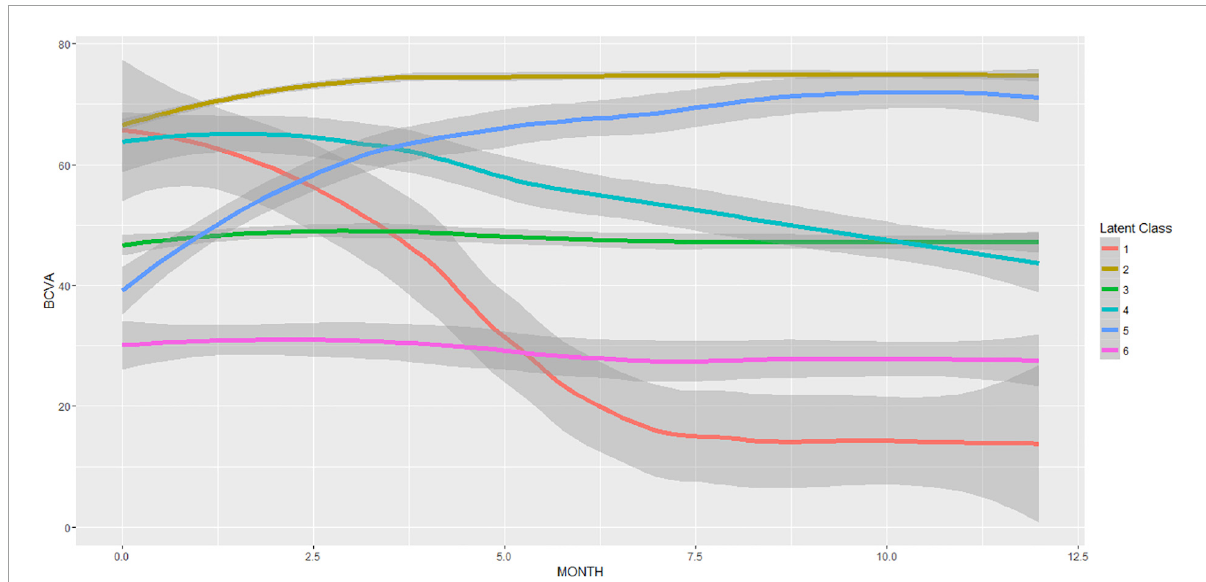
FIGURE4 Latent class mixed model (LCMM) with six latent classes of the BCVA trajectories during the T&E treatment. The resulting mean ( ± 95% CI) BCVA trajectories are displayed. The number of patients per latent class was 1:4, 2:173, 3:58, 4:12, 5:15, 6:8. Responders (latent classes: 2,5) and non-responders (latent classes: 1,3,4,6) are clearly distinguishable.